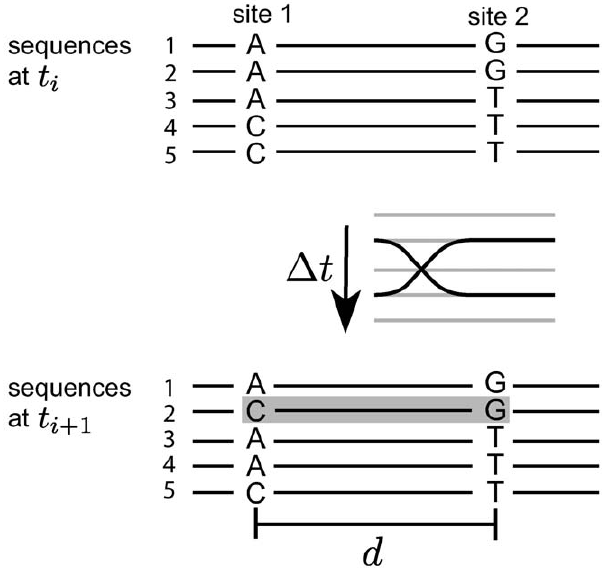
Figure 1. Recombination produces new haplotypes. At time point t i , a pair of polymorphic sites is observed in three different combinations A … G , A … T , and C … T . Recombination can generate the missing haplotype C … G (grey box) from one time point to the next with a rate proportional to the product of the distance d between the two sites and the time interval D t between the two observations. Since no other process depends on this combination of parameters, we can estimate the recombination rate using this dependence.